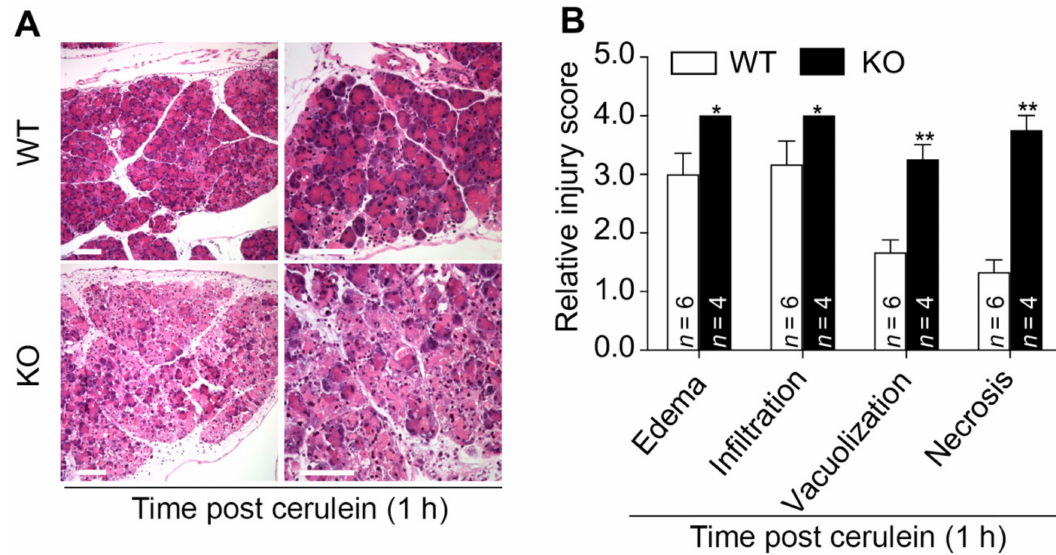
Figure 3. Mfge8 knockout (KO) mice develop more severe cerulein-induced acute pancreatitis than wild type (WT) mice. WT and Mfge8 KO mice (male, 8–10 weeks old) were administered 10 hourly doses of cerulein to induce acute pancreatitis. Animals were euthanized 1 h after the last cerulein treatment. ( A ) Representative images of H&E-stained pancreatic tissue slides. ( B ) Histopathology scores of indicated inflammatory parameters were quantified as described in Table 1. * p < 0.05 and ** p < 0.01 versus cerulein-treated WT mice. Scale bar: 100 µ